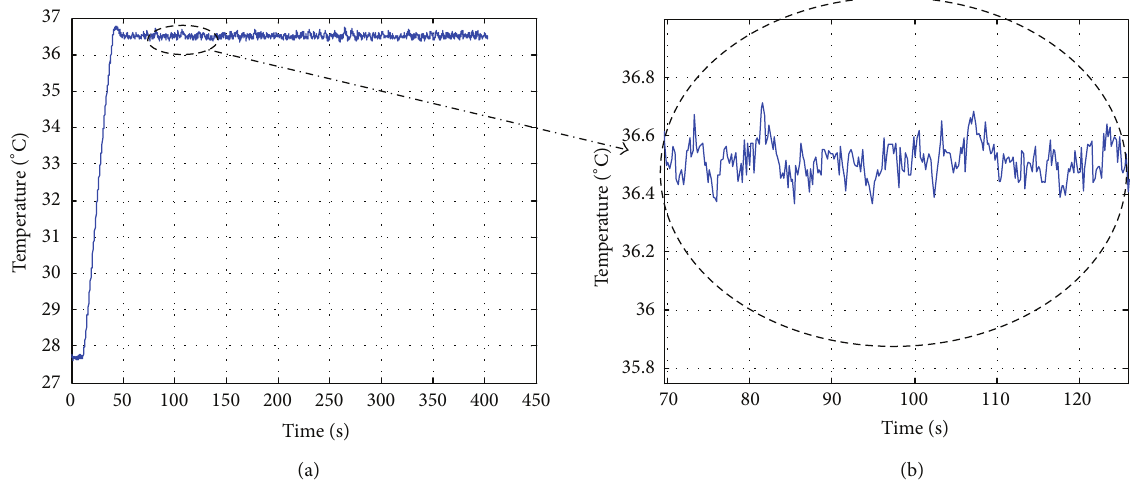
Figure 17: (a) Temperature characteristic of temperature closed-loop control circuit with start temperature at 27.68 ∘ C. (b) Temperature characteristic partial enlarged